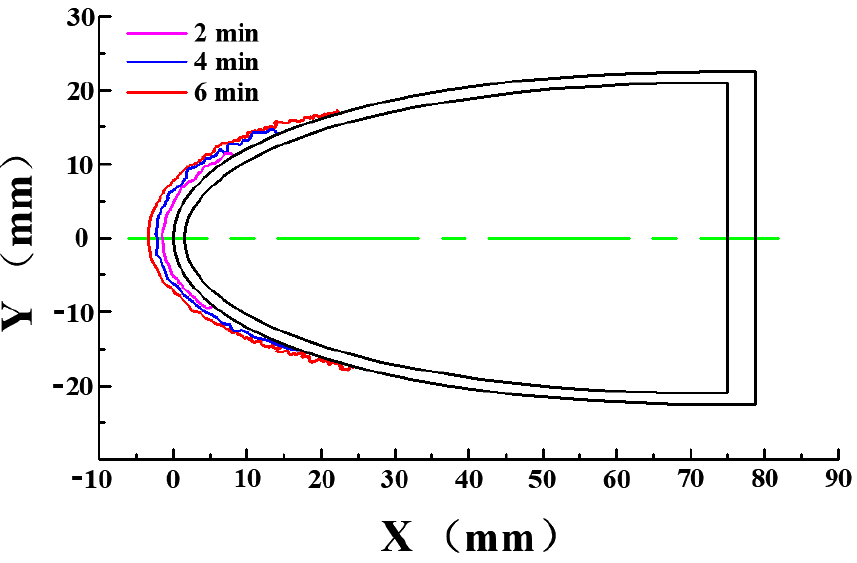
Figure 11. Ice on the blade surface.